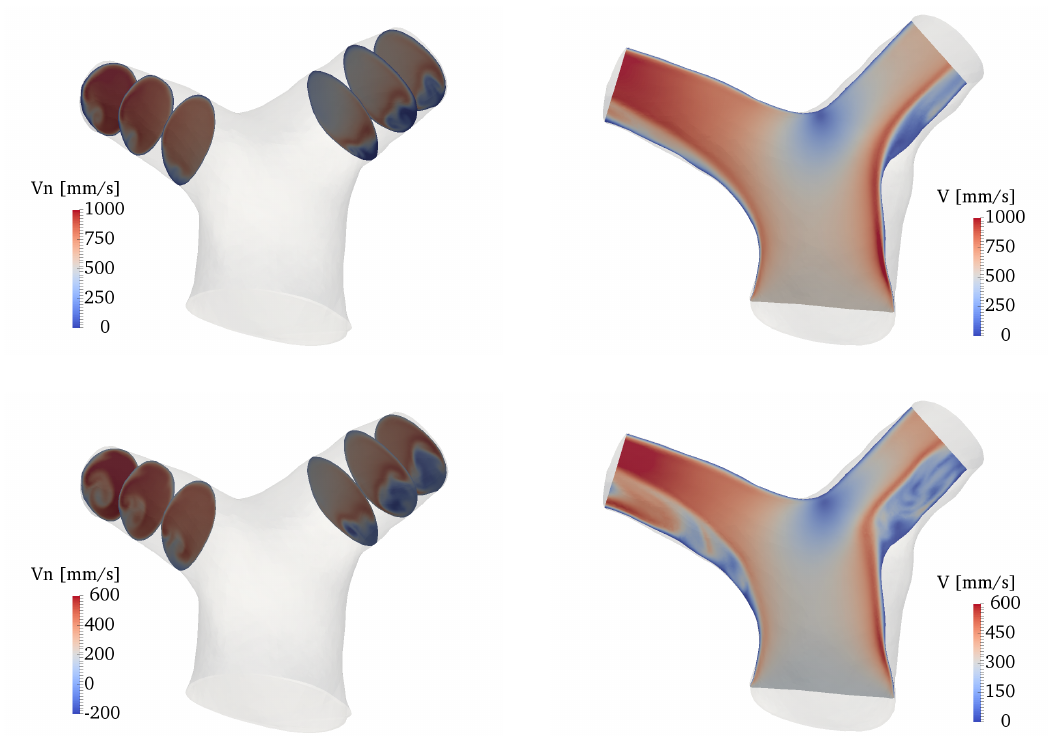
Figure 8. Contour plots of the velocity field along several slices of the domain. From top to bottom: acceleration, peak systole and deceleration phases. Left: normal velocity at various locations of the LPA and RPA. Right: velocity magnitude in a slice cutting the whole